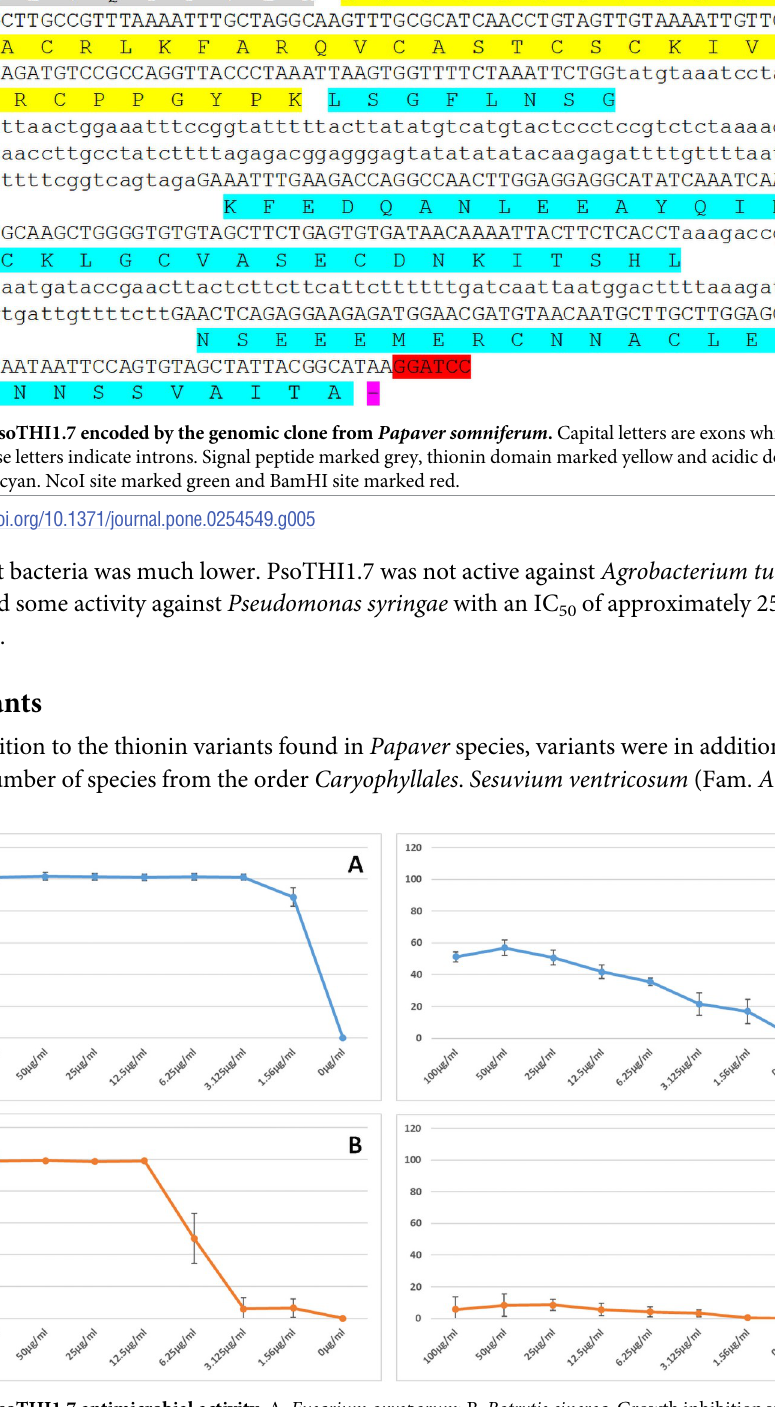
Fig 6. PsoTHI1.7 antimicrobial activity. A, Fusarium oxysporum ; B, Botrytis cinerea . Growth inhibition was calculated after growth for 48h. Values are from 3 biological replicates with standard deviation. C, Pseudomonas syringae ; D, Agrobacterium tumefaciens . Growth inhibition was calculated after growth for 24h. Values are from 3 biological replicates with standard deviation.